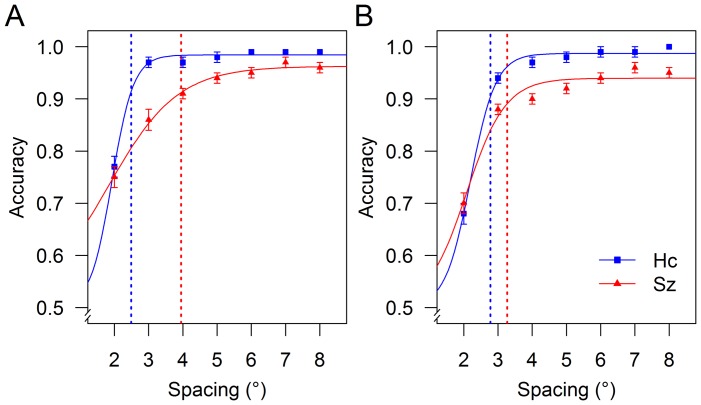
Accuracy and fitted logistic curves as a function of spacing at 8° eccentricity (panel A) and 10° eccentricity (panel B) in schizophrenia patients and healthy controls.Vertical dotted lines indicate critical spacing. Values represent the mean ± standard error of mean.